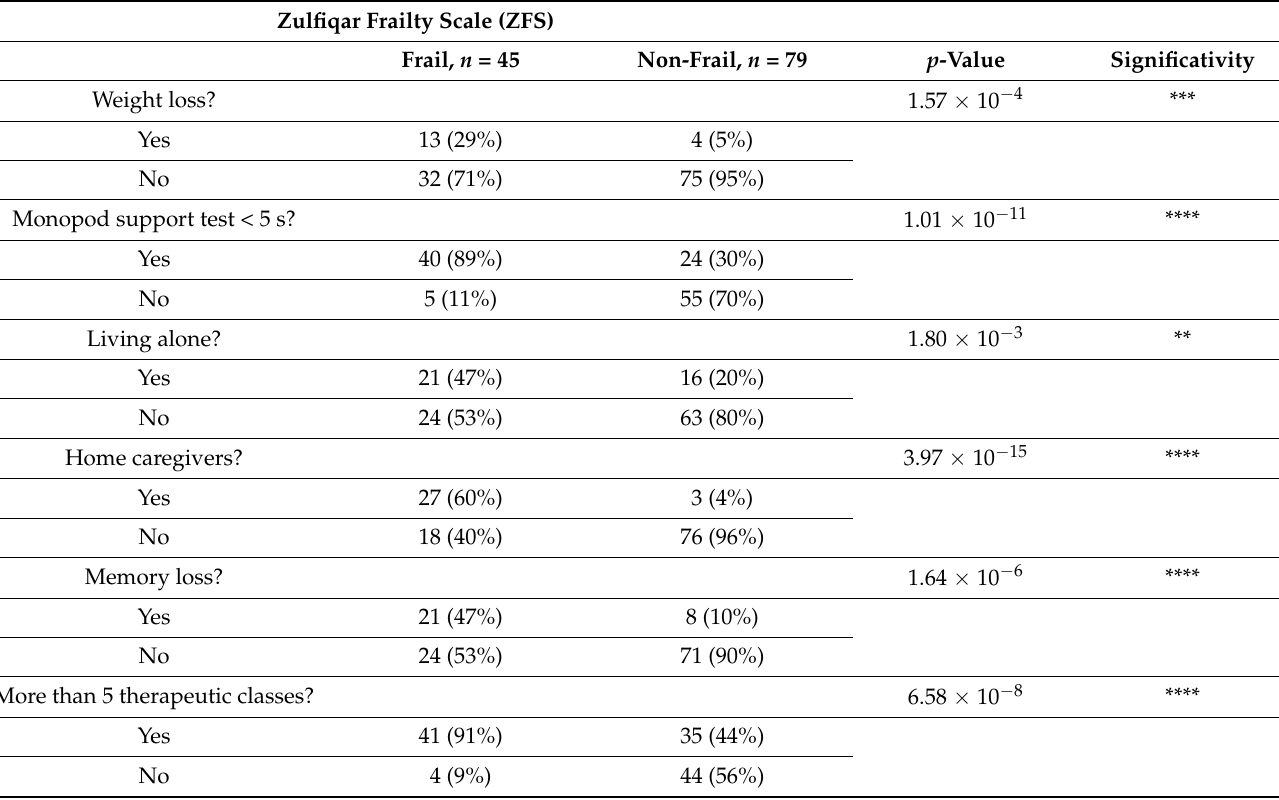
Table 4. Presents a comparison of the element scores of the Zulfiqar Frailty Scale between frail and non-frail